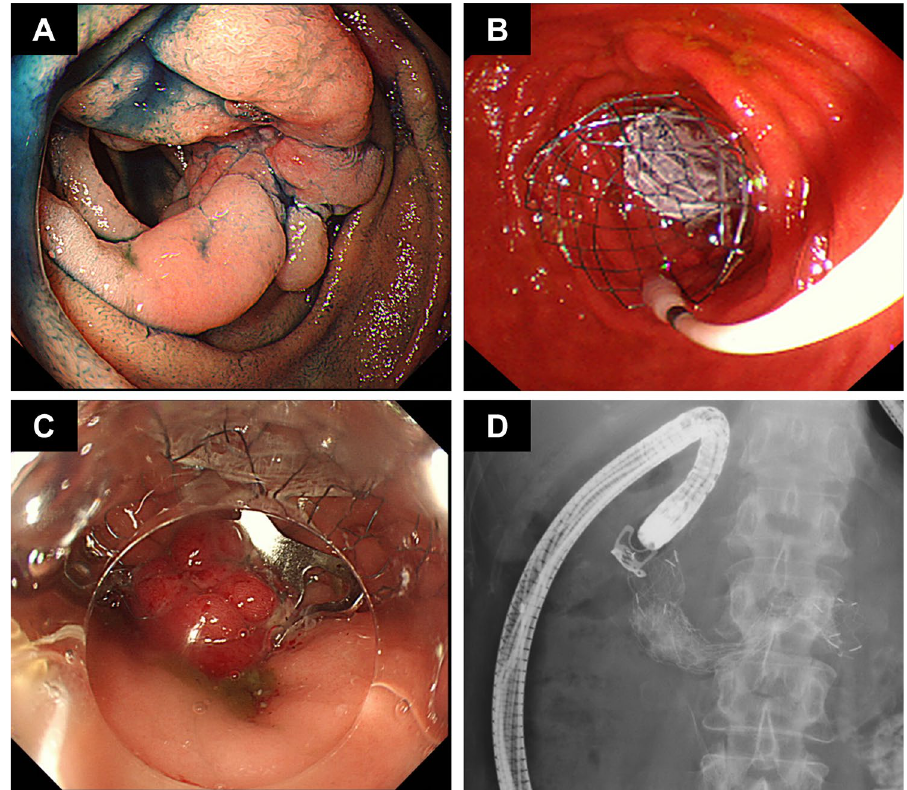
Figure 3. A 60-year-old female with pancreatic cancer. The third portion of the duodenum was obstructed by the tumor ( A ), and a partially covered self-expandable metal stent (PC-SEMS) was deployed ( B ). The over-the- scope-clip (OTSC) system was loaded onto the endoscope, and part of the upper rim of the metal stent was suctioned into the transparent cap. The OTSC was released to grasp both the metal stent and duodenal wall ( C ). A fluoroscopic image after OTSC and PC-SEMS placement ( D